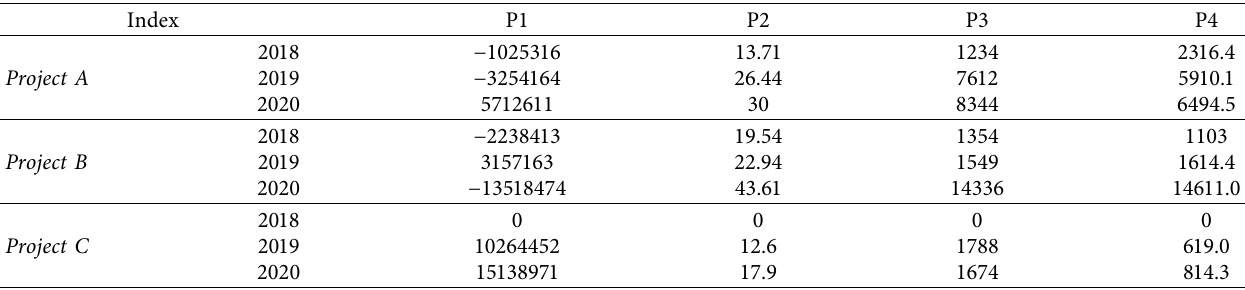
Amount of Figure 9: Error results between predicted and true values. (a) Absolute temperature error. (b) Relative temperature error. Table 1: Project index data.